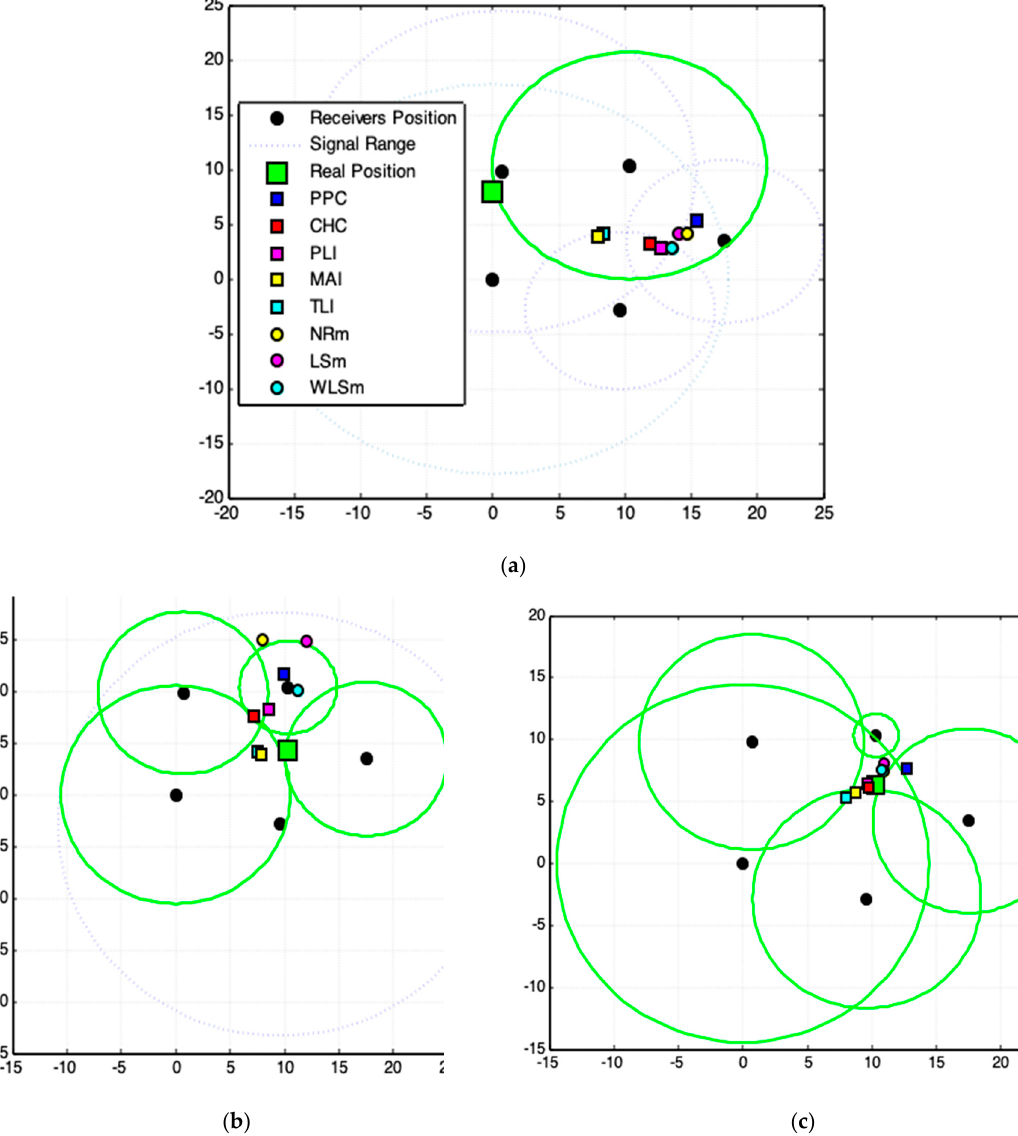
Figure 17. Some particular experimental results. ( a ) The worst case. ( b ) An intermediate case. ( c ) The best case. The blue-dotted circle lines show the receivers/emitters that suffered severe interferences and promoted the acquisition of data with